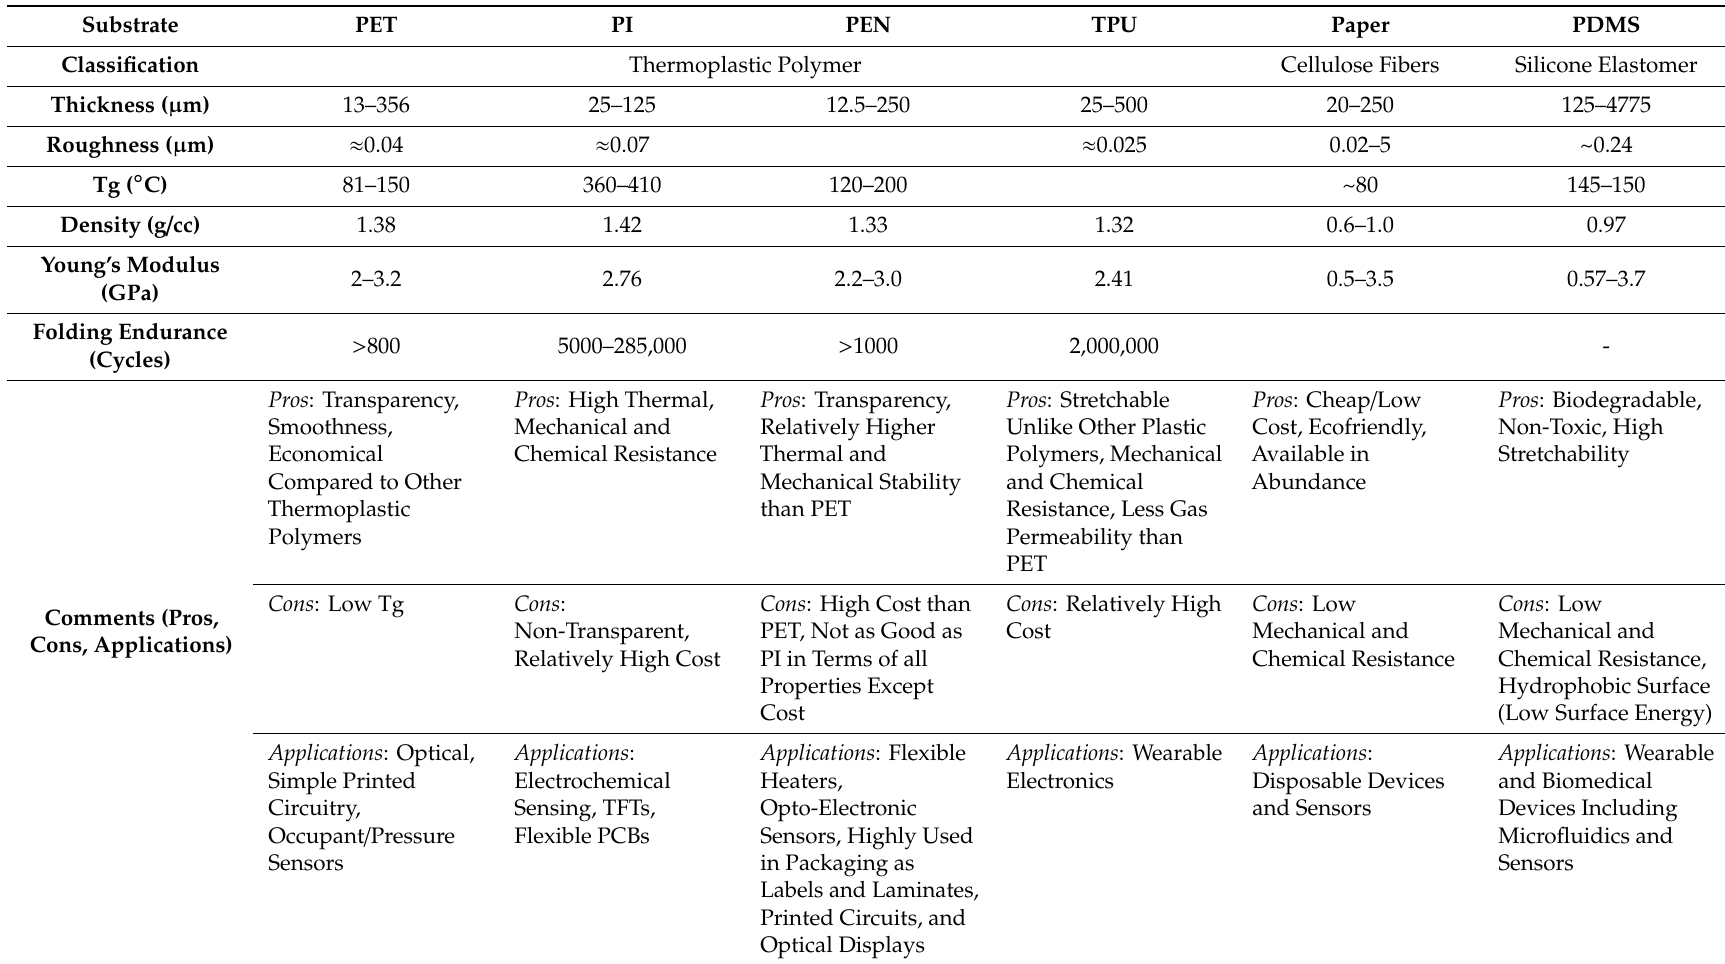
Table 1. Specifications of various substrates employed in printed electronics